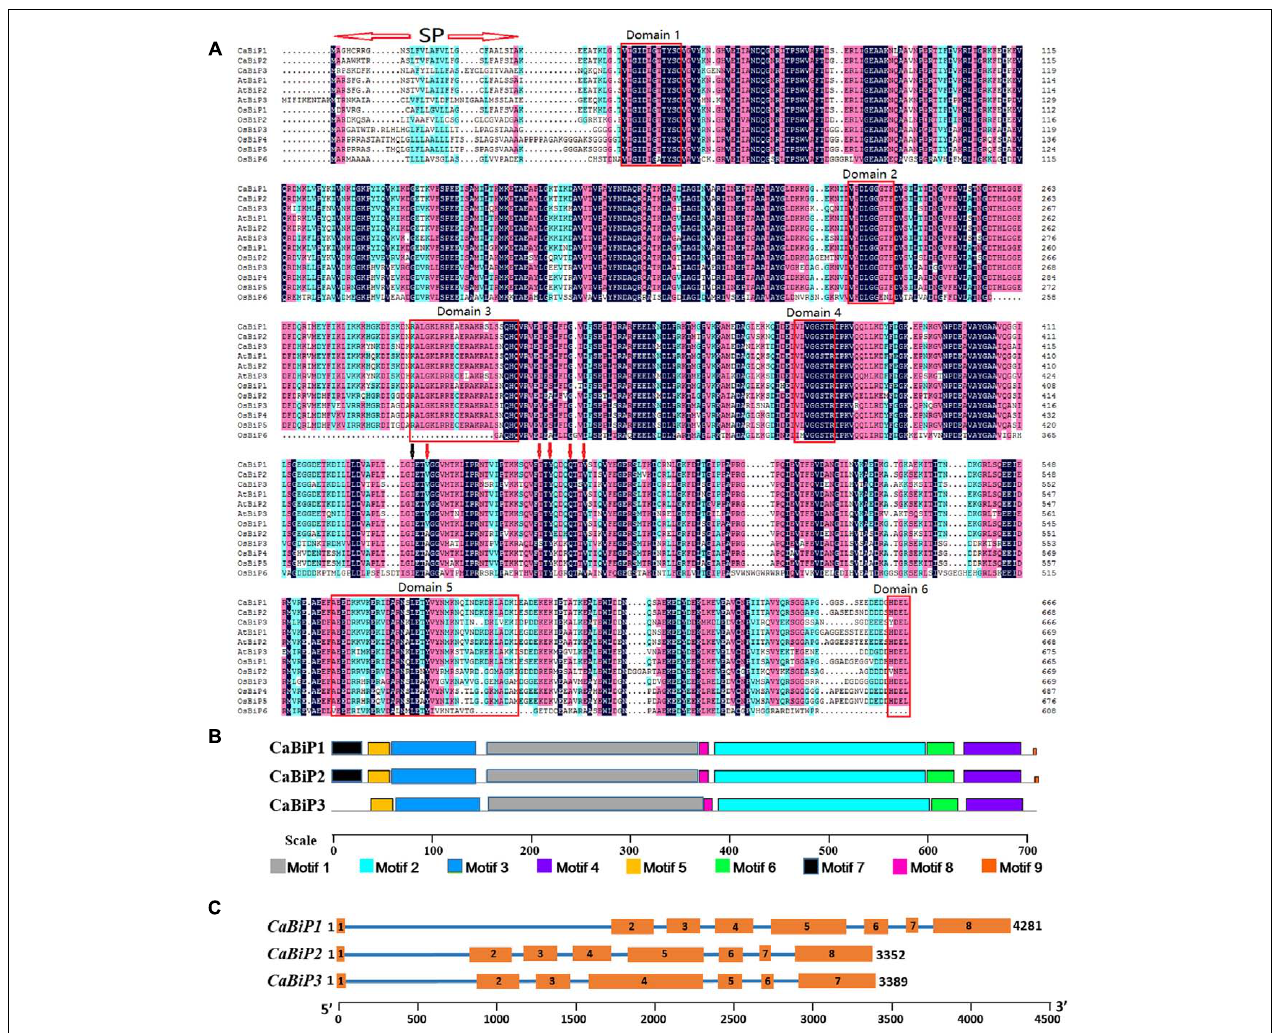
FIGURE 2 | Sequence analysis of CaBiP genes. (A) Conserved amino acid domains in CaBiPs shown by amino acid sequence alignment with orthologs in Arabidopsis and rice. SP, the signal peptide. Red arrows indicate hydrogen bonds, black arrow indicates the the cut-off point GI. (B) Motifs of CaBiP proteins identified by MEME tools. Different motifs are indicated by different colors. (C) Distribution of introns and extrons in CaBiP genes. Blue lines = introns, orange rectangles =